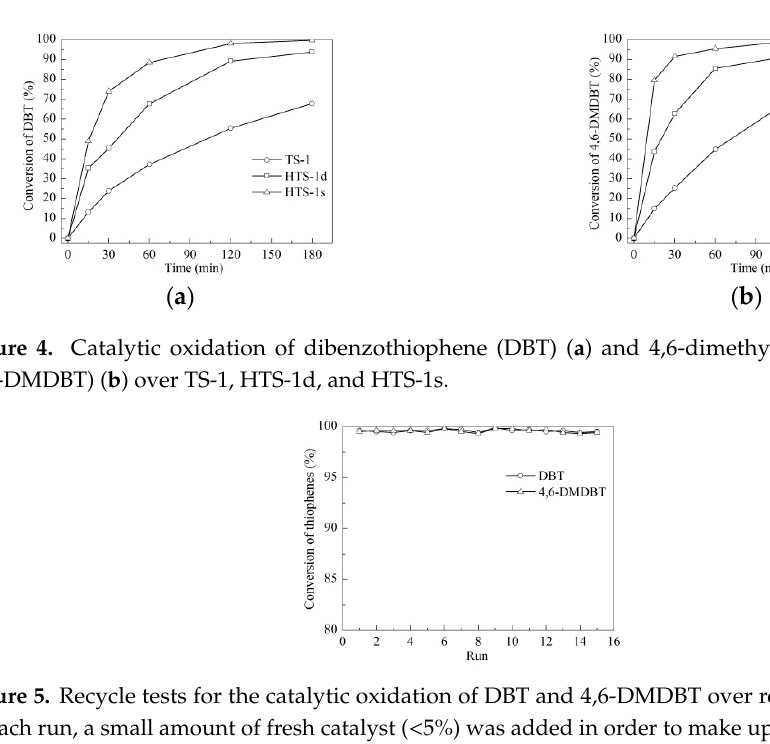
Figure 5. Recycle tests for the catalytic oxidation of DBT and 4,6-DMDBT over regenerated HTS-1s. In each run, a small amount of fresh catalyst (<5%) was added in order to make up for the loss during the recovery process.